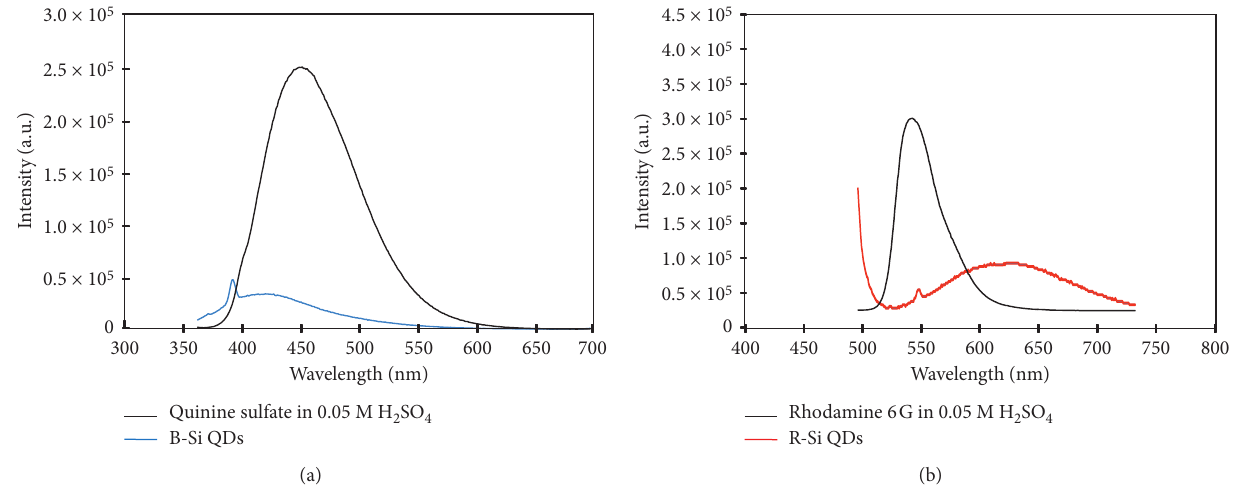
2 SO 4 and rhodamine